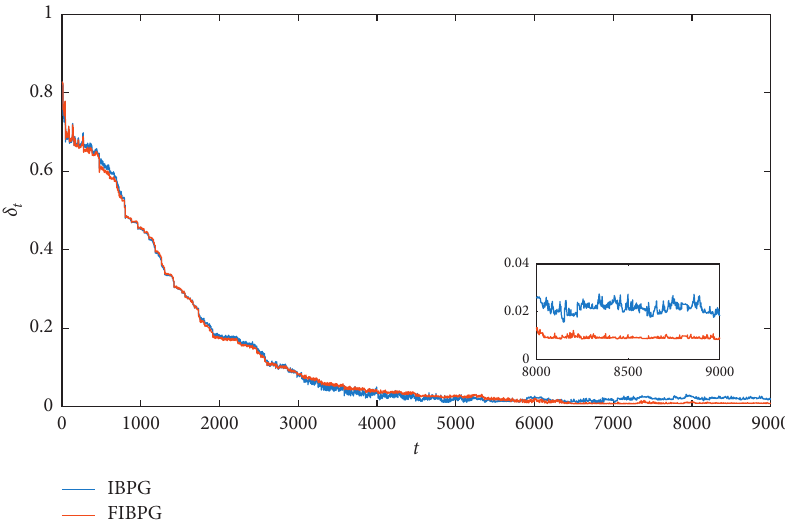
Figure 10: Evolution curves of parametric error for the FSOEAHW model using FIBPG algorithm. Table 6: The vector parameter estimates 􏽢 θ t and their parametric errors δ t for the FSOEAHW model using FIBPG algorithm. FIBPG